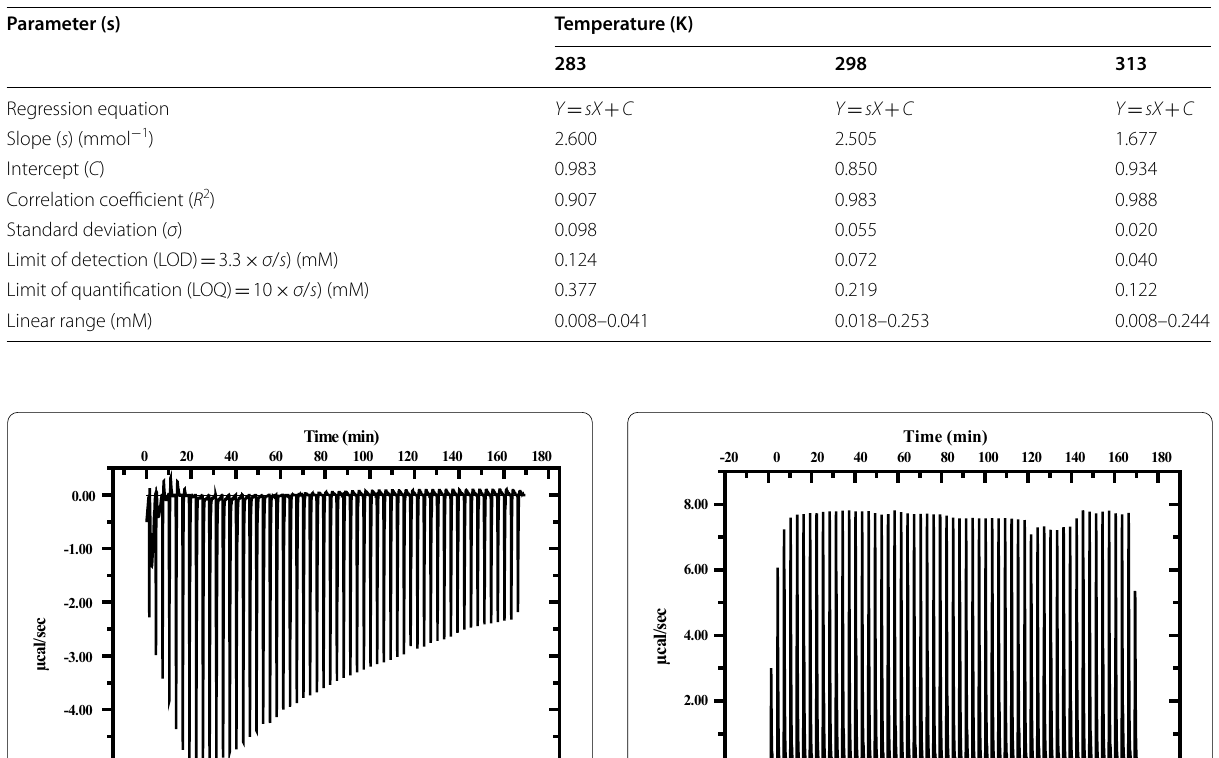
Table 2 Different analytical parameters for the detection of F